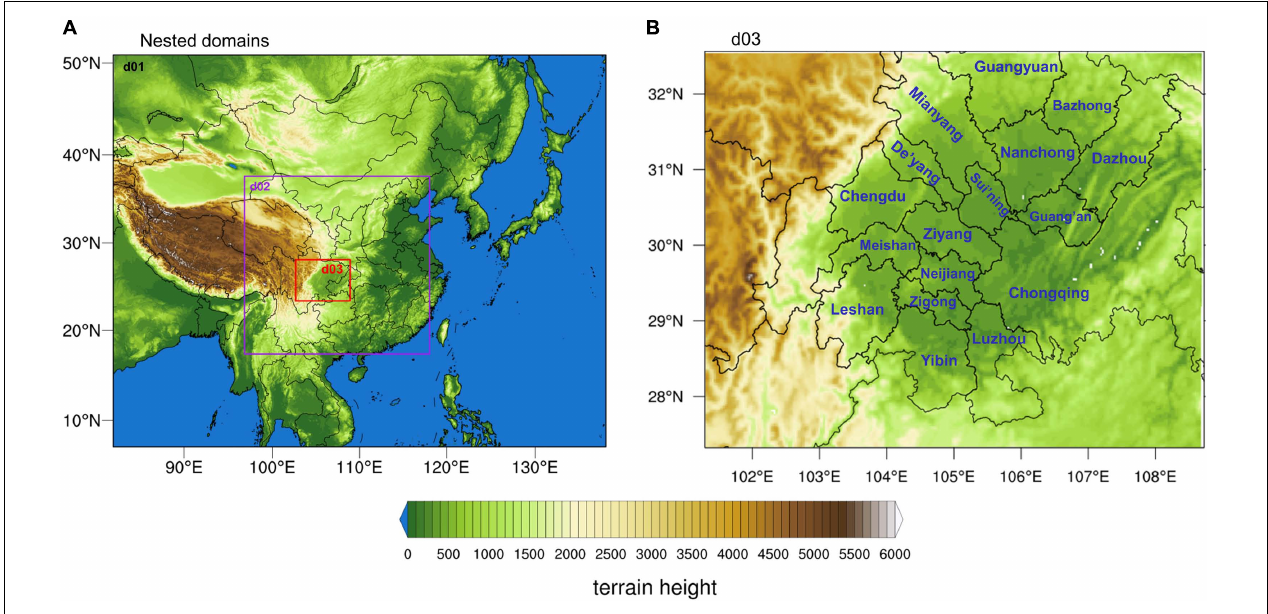
FIGURE 1 | Three nested WRF domains with terrain height (m) (A) domain configurations, (B) innermost domain.